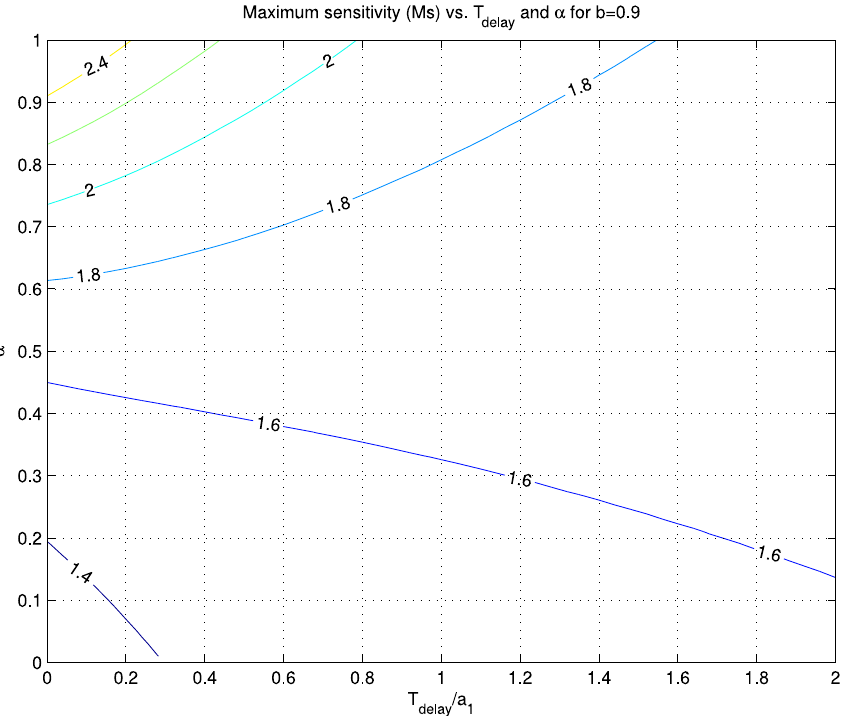
Figure 6. Closed-loop maximum sensitivity (M S ) for G ( s ) and controller parameter b = 0.5 at different values of process parameters T delay and α.